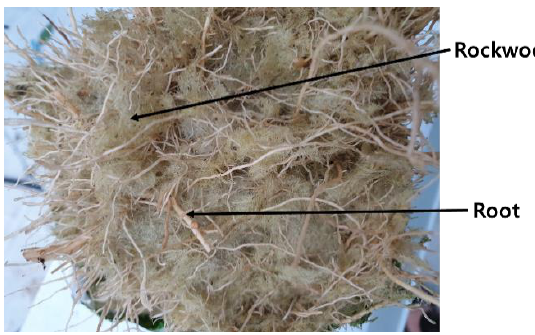
Figure 2. Distribution of roots inside the rockwool growing medium.